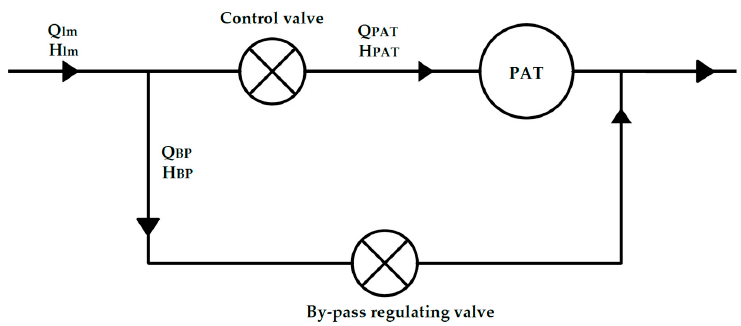
Figure 3. Typical PAT installation scheme.